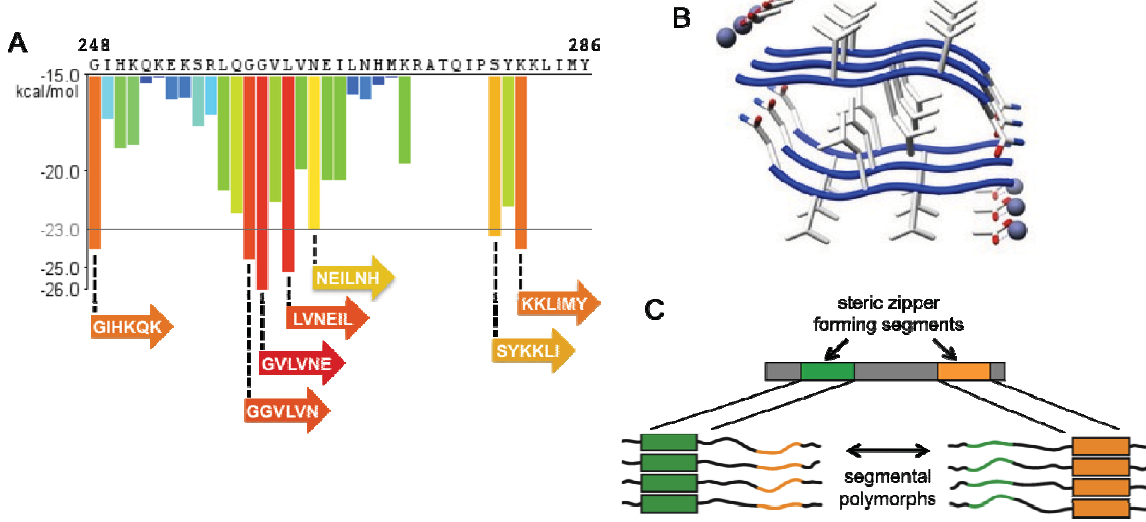
Figure 4. PAP248-286 has several regions of high amyloidogenic propensity. ( A ) Zipper DB [65] prediction of fibril-forming segments of PAP248-286. The propensity profile graph predicts hexapeptide segments (beginning at the indicated residue) that are highly likely to assemble into amyloid fibrils. Orange-red segments with energy values below the indicated threshold of (cid:3)23 kcal/mol (gray line) are expected to form steric-zipper spines of fibrils. PAP248-286 contains seven hexapeptide segments of high amyloidogenic propensity; ( B ) The hexapeptide segment 260 GGVLVN 265 (energy = (cid:3)24.5 kcal/mol) is one of the seven segments predicted to form fibrils. The steric-zipper structure of this hexapeptide has been solved (PDB ID: 3PPD). Acetic acid and zinc ions are shown associated with the structure and might indicate how SEVI engages phospholipids and tethers membranes [66]; ( C ) An amyloid-forming protein with two segments (green and orange) capable of forming steric zippers can exist as segmental polymorphs, in which each segment can form the amyloid